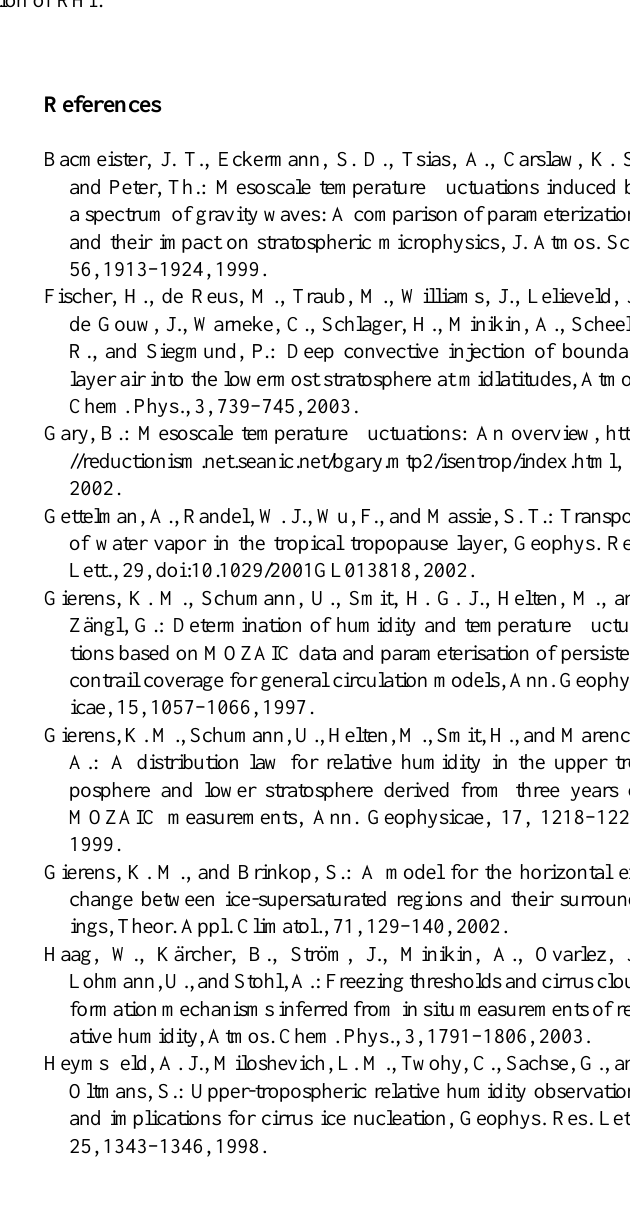
Fig. A1. Comparison between Gaussian temperature distribution and resulting quasi-exponential distribution of RHI (solid curves, left and right panel, respectively) with corresponding analytical solutions valid at low temperatures and high relative humidities (dashed curves) describing an exact asymptotic exponential decrease of the distribution of